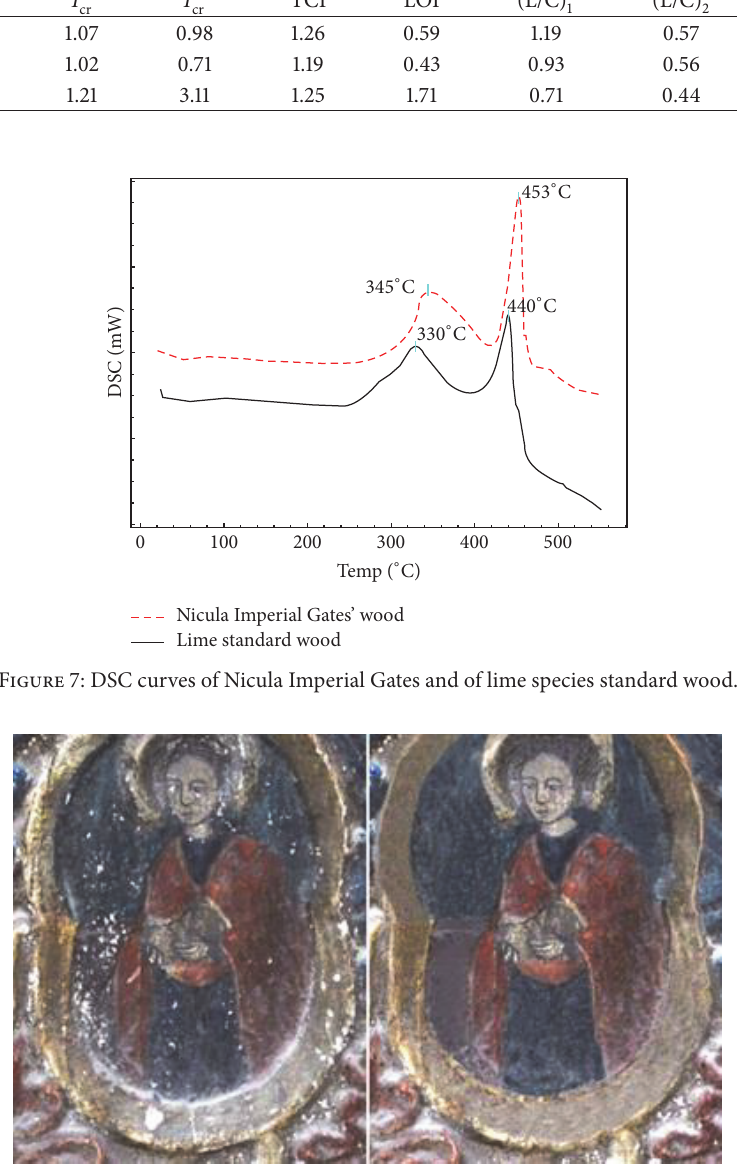
Figure 8: The restoration of the painted layer with the current